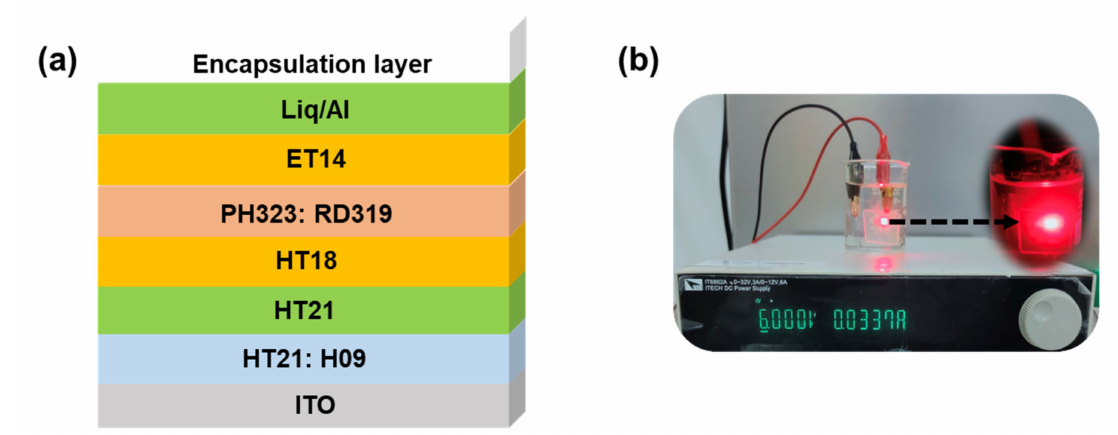
Figure 2. ( a ) Device structure in the present study and ( b ) a photograph showing Devices R3 subjected to water immersion for 48 h and continuously driving at 6